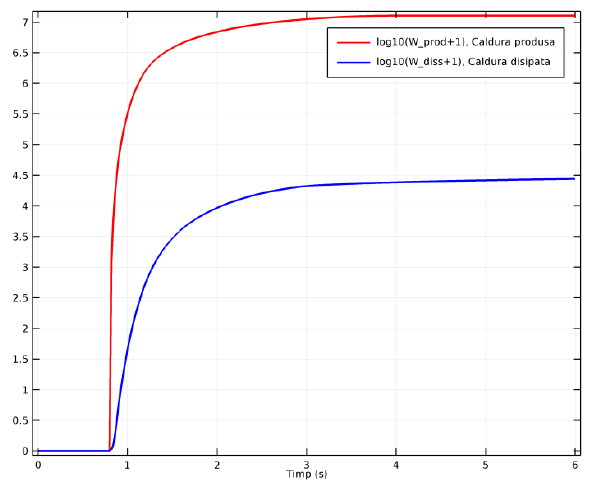
Figure 25. Comparison of the generated (red line) and dissipated heat (blue line).